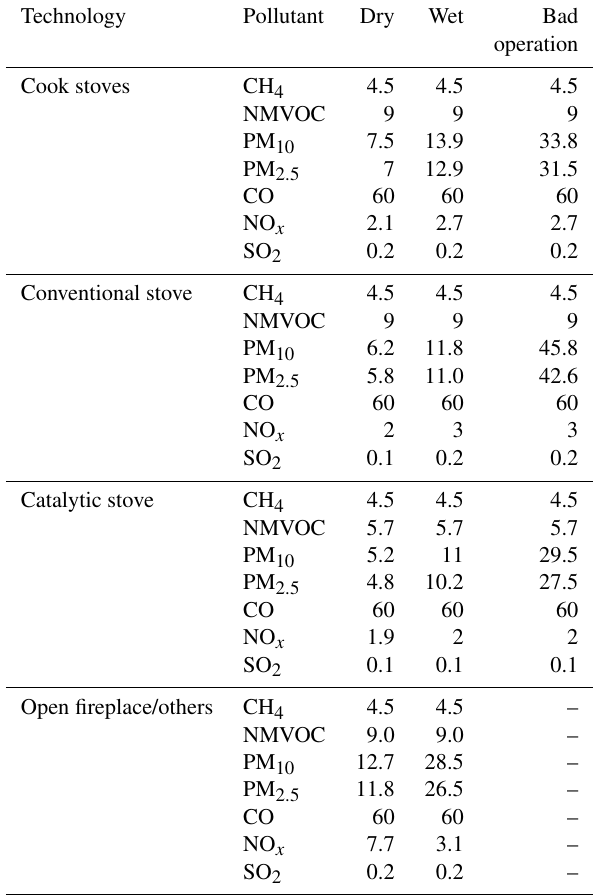
Table A1. Emission factors (gkg − 1 ) for the residential sector by technology (appliance type), humidity and operation device condi- tions.